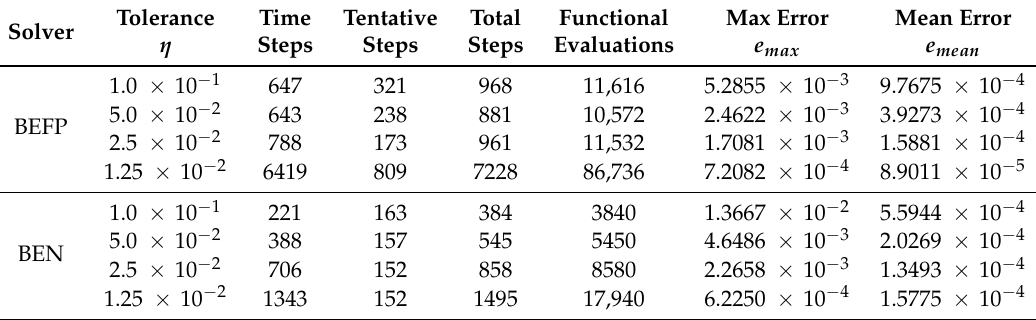
Table 8. Results of the shifted quasi linear iterative splitting for the MCDB equation with µ = 0.5.